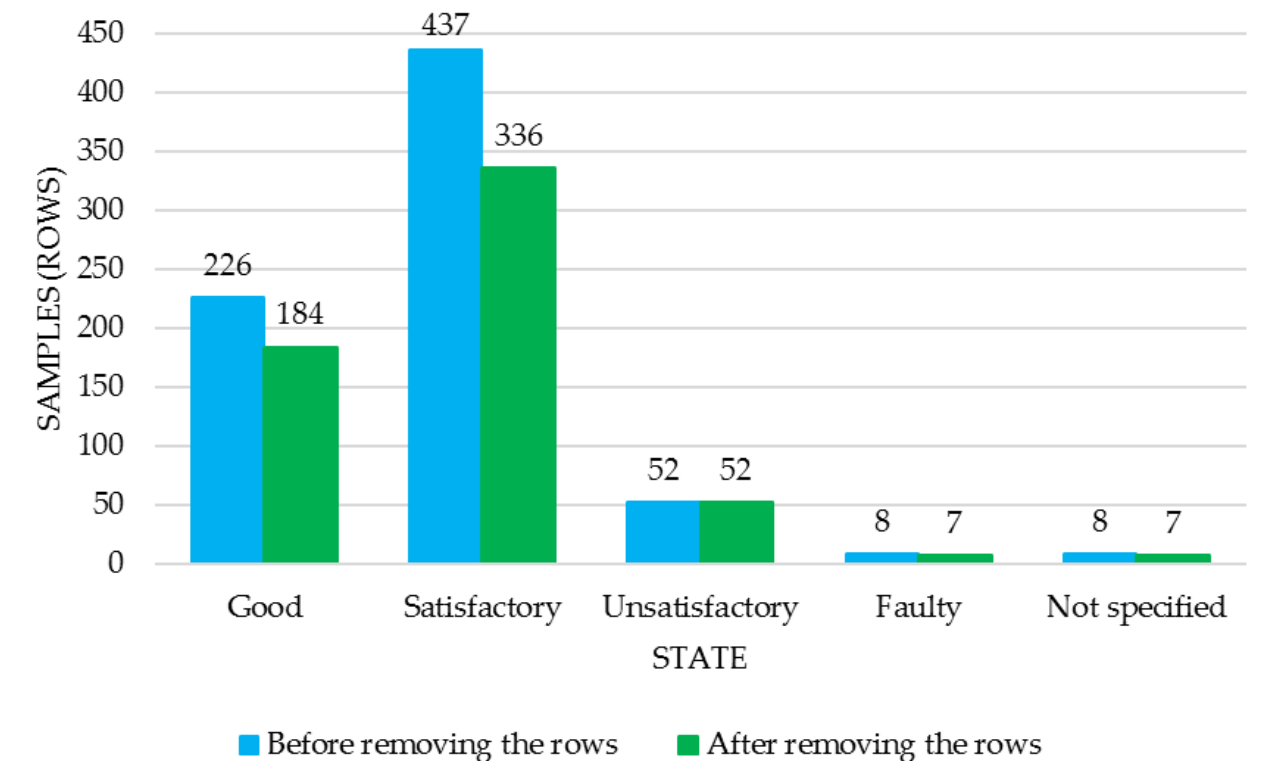
Figure 3. Data area diagram for a power transformer dataset after excluding columns and rows with a large number of gaps.